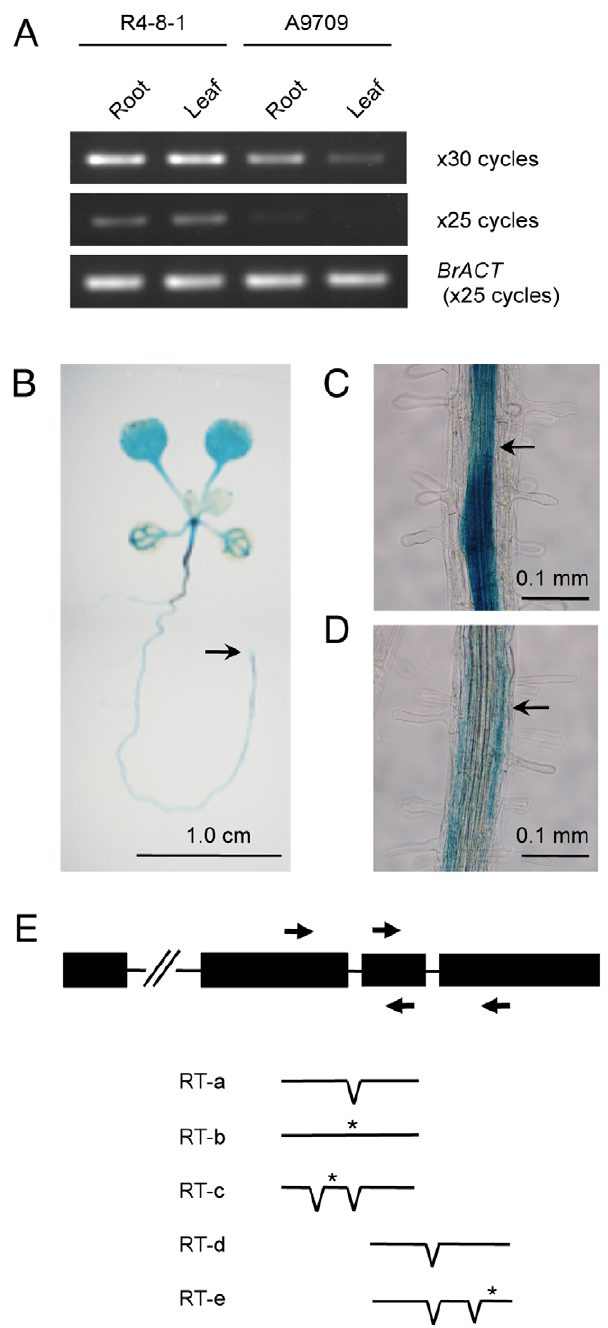
Figure 5. Expression analysis of Crr1a . A. Semi-quantitative RT-PCR analysis of Crr1 in resistant (R4-8-1) and susceptible (A9709) lines. The B. rapa actin gene ( BrACT ) was used as a control. PCR cycles are indicated on the right. B-D. Spatial expression of Crr1 G004 shown as GUS staining in (B) 12-day-old seedlings of Crr1 G004 promoter:: GUS plants (arrow indicates extreme end of primary root), (C) stele (arrow) of primary root, and (D) cortex (arrow) of primary root. E. Schematic diagram of gene structure of Crr1a G004 and alternative transcripts obtained by RT-PCR using primers flanking introns 2 (RT-a, -b, and -c) and 3 (RT-d and -e). V- like lines, spliced introns; asterisks, predicted stop